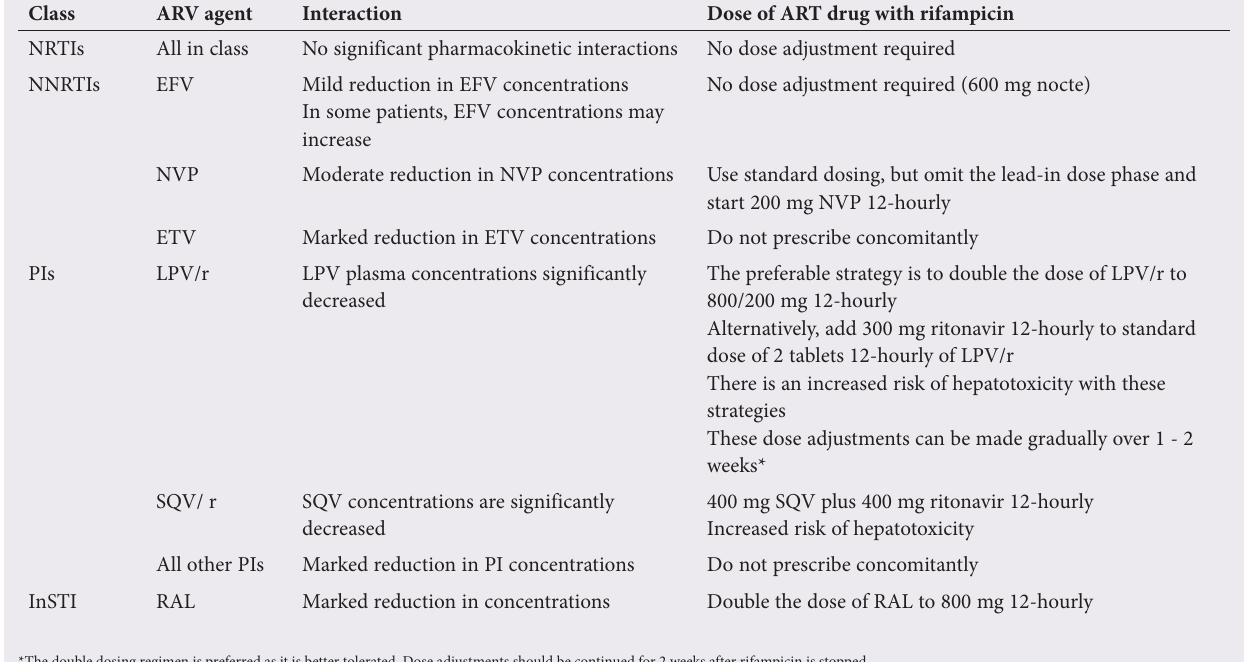
Table 6. ART interactions with rifampicin and recommendations for co-administration